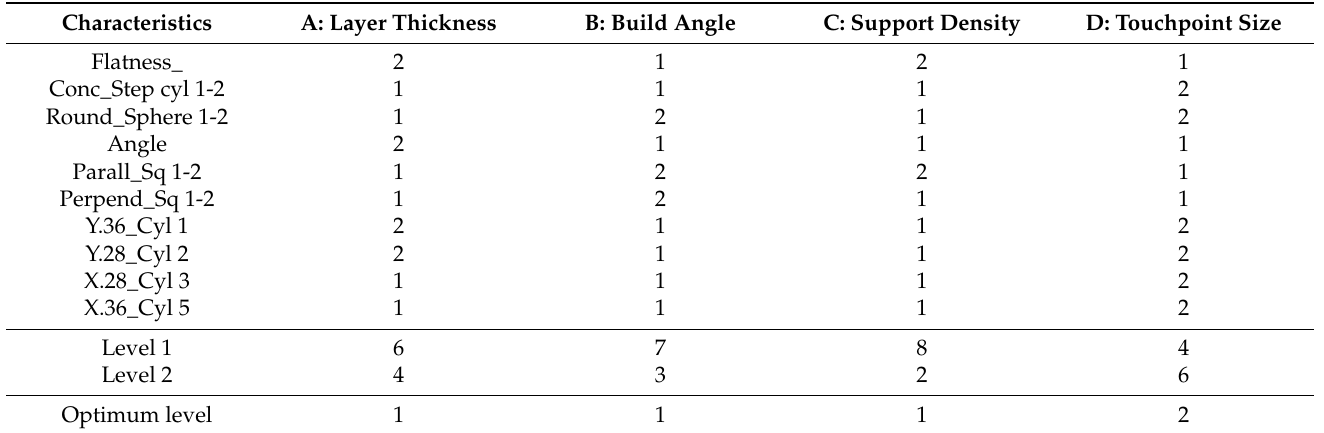
Table 14. Optimum levels of parameters for geometric characteristic of patterns.